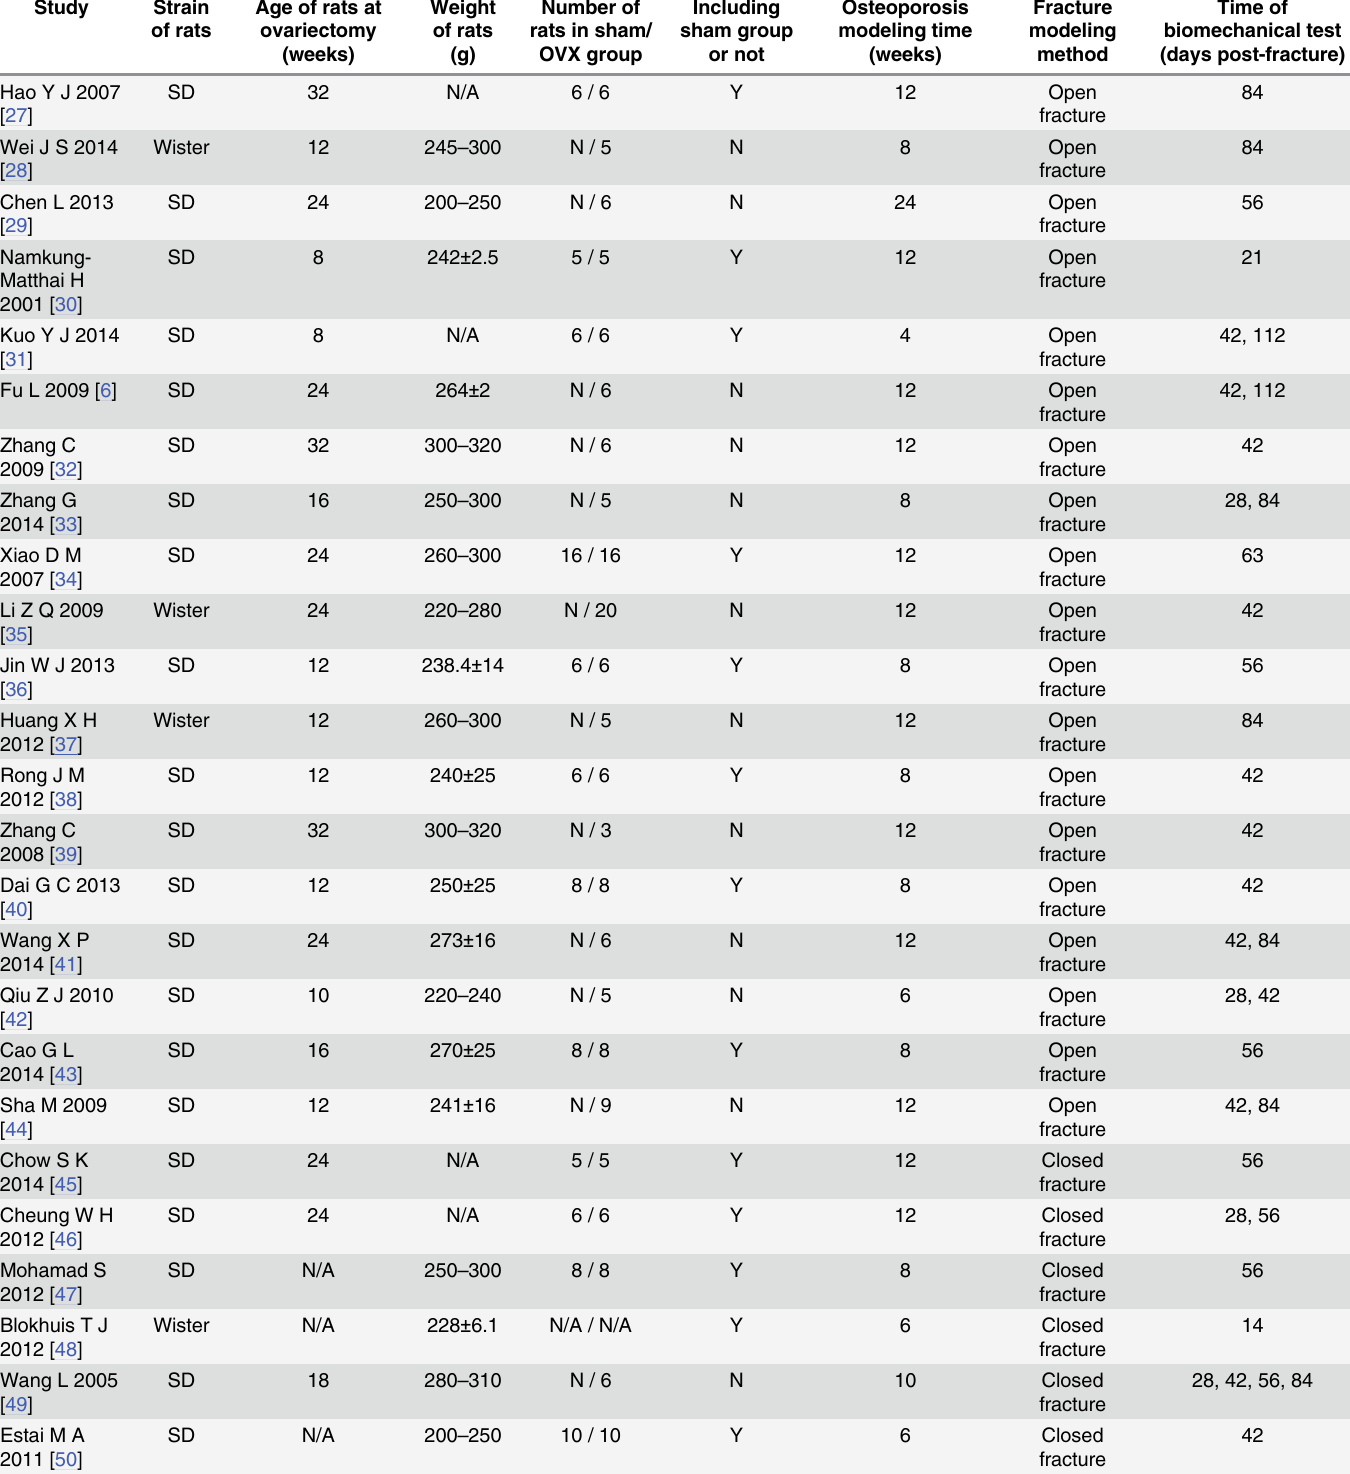
Table 1. Description of the characteristics of included